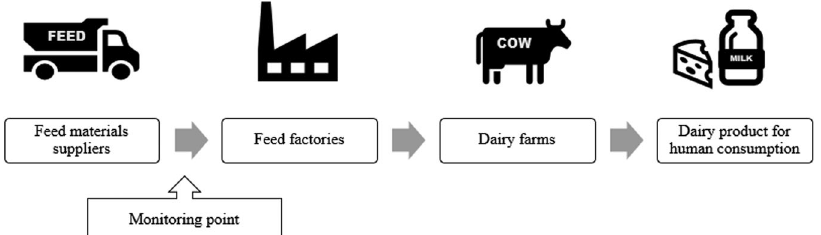
Fig. 4 A simpli fi ed feed supply chain. The monitoring point along the feed supply chain for AFB1 was set prior to feed material entry feed